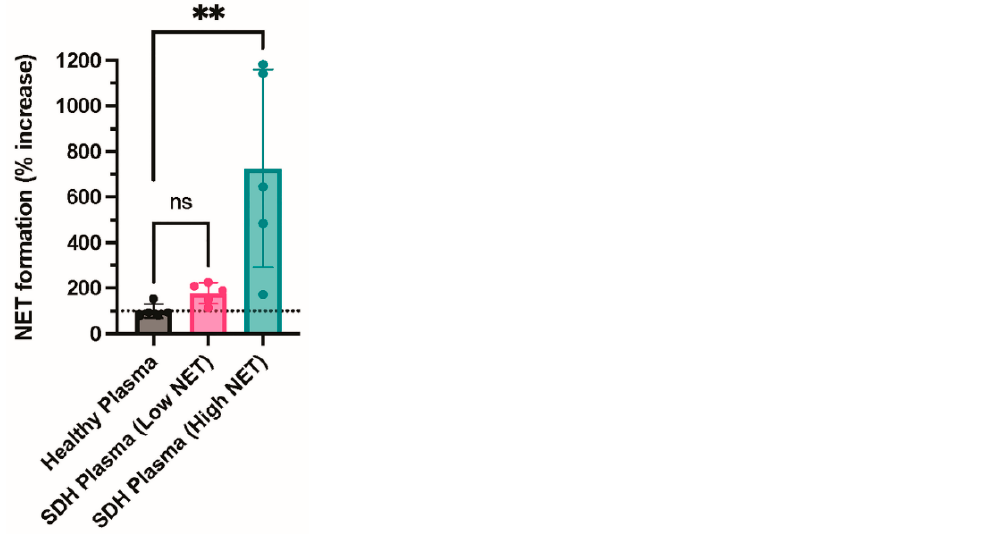
Figure 4. NASH fluid increases NETosis in healthy neutrophils compared with healthy plasma. Neutrophils were isolated from healthy donors using CD15+ selection. Neutrophils were incubated with buffer (resting), healthy plasma, or fluid from NASH samples for one hour. After one hour, neutrophils were resuspended in M199 media and allowed to undergo NETosis. Cell-free media was collected, and NET formation was measured by cell-free DNA release (N = 5 per group). ** p ≤ 0.01. ns= not significant.